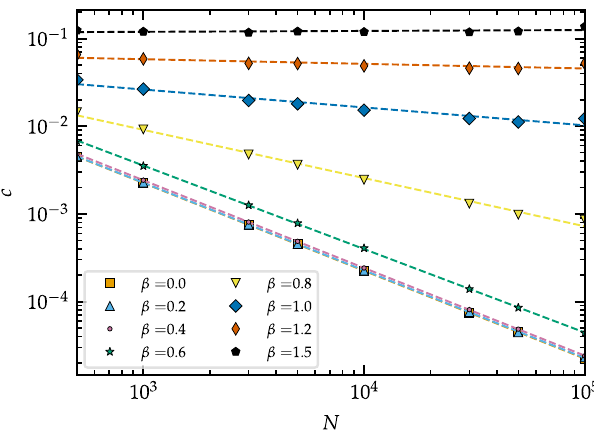
Fig. 3 The average local clustering coef fi cient as a function of the network size. The networks were generated by applying the DPG technique to a con fi guration model network with a homogeneous degree sequence k = 4, ∀ k . Dashed lines are power law fi ts used to estimate the exponent σ ( β ) de fi ned as (cid:2) c (cid:3) N (cid:2) σ ð β Þ . Errorbars representing the standard error are smaller than the data points and therefore not displayed.